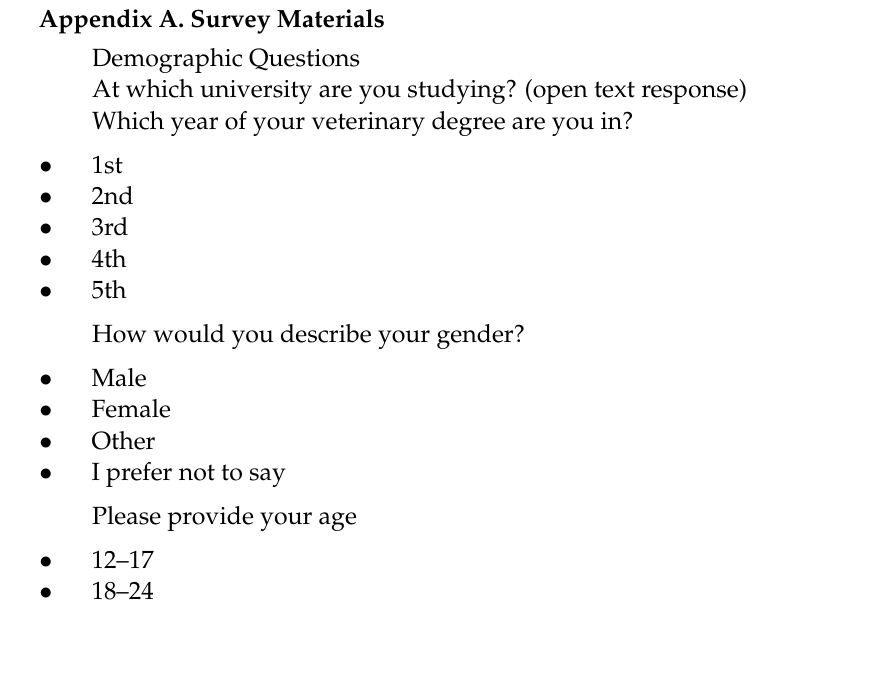
Table S4: Kruskal-Wallis tests for differences in mean beliefs (responsibility for preventing ABR) for whole early years sample between universities. Table S5: Mann-Whitney tests for differences in beliefs between early and later years University of Surrey